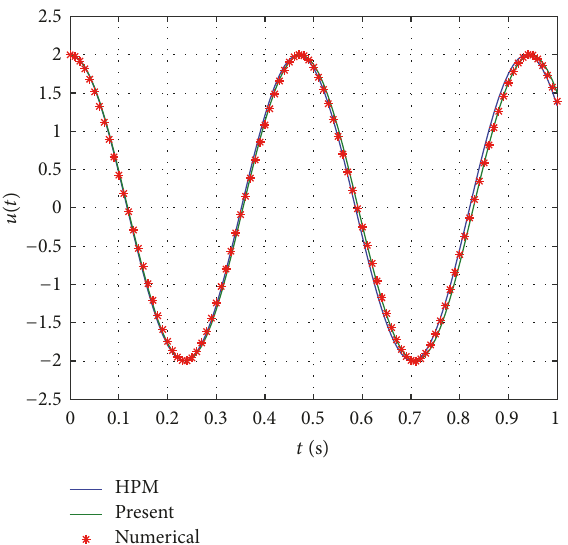
Figure 12: Comparison of time history diagram of displacement between the Present, HPM, and numerical solutions at 𝛼 = 10, 𝛽 = 100, 𝐴 = 2 , Example 4.